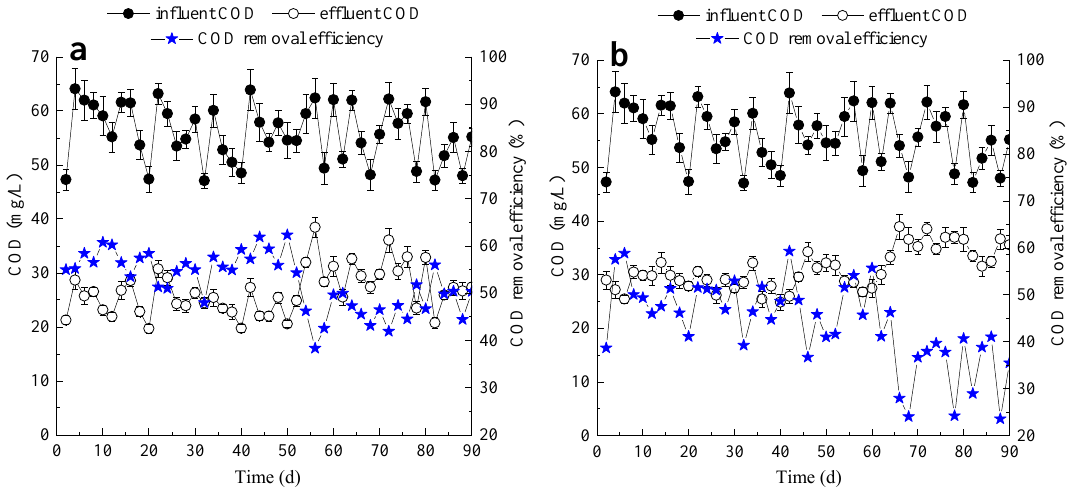
Figure 3. Chemical oxygen demand (COD) removal performances in the VFCW ( a ) and HFCW ( b ) ecosystems under different influent loads. The results were the averages and their standard deviations.